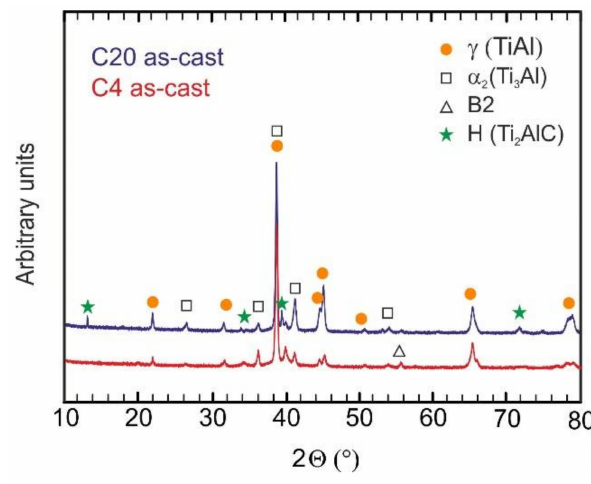
Figure 5. The typical X-ray diffraction patterns of C4 and C20 alloys.